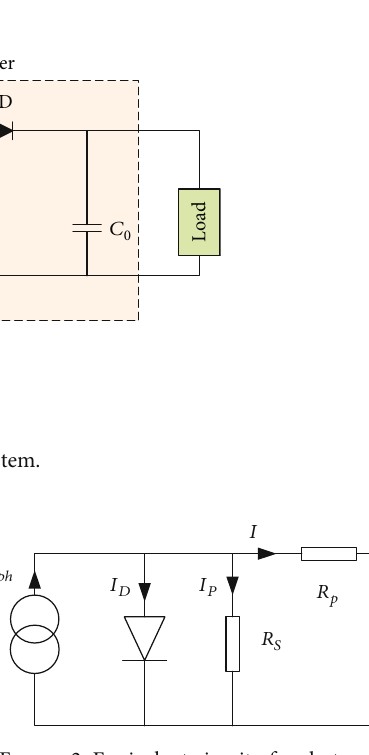
Figure 2: Equivalent circuit of a photovoltaic